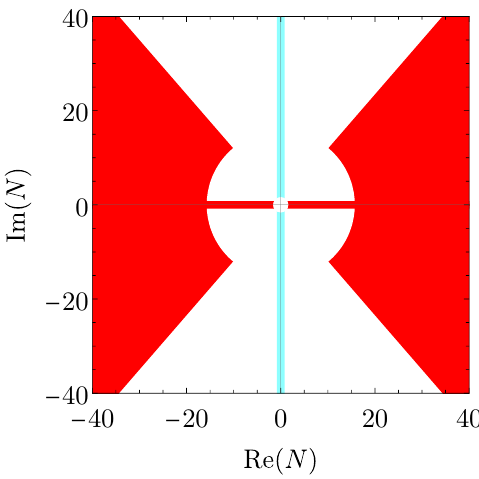
Figure 5 . Analytical results for the classical transition from q 0 = 2 to q 1 = 10 . The red regions rep- resent the asymptotic region of non-allowability (3.10) (starting at | N | = 15 . 5 ) and the Lorentzian axis (proved to saturate the LSKSW bound in section 2.4), while the Euclidean axis highlighted in cyan is allowable. The saddle points are not shown, but they are located at N SP = ± 2 , ± 4 , so the region of particular interest for the path integral (e.g., N . 6 ) remains unconstrained at this